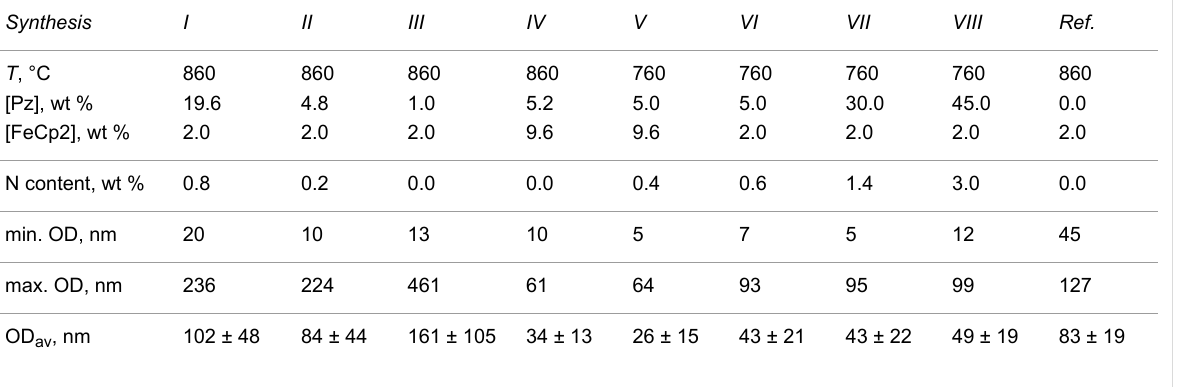
Table 4: Summary of the results from measurements of OD N-CNTs’ from Syntheses I–VIII and MWCNTs from Ref. Synthesis . Synthesis